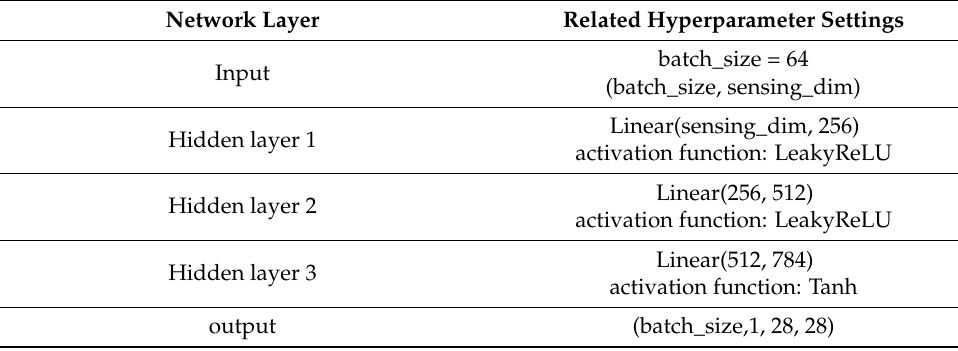
Table 3. Hyperparameter Settings of multi-layer perceptron generative